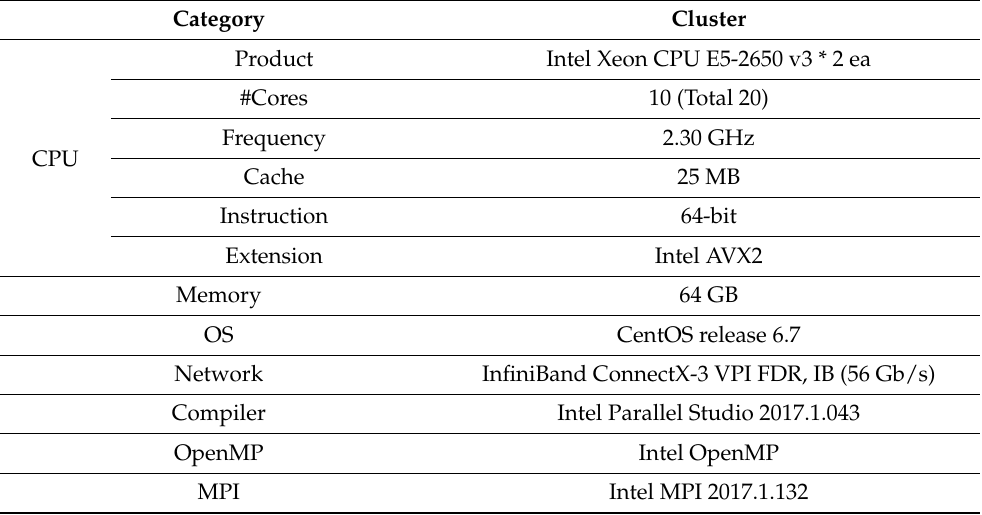
Table A5. Specification of the parallel performance evaluation